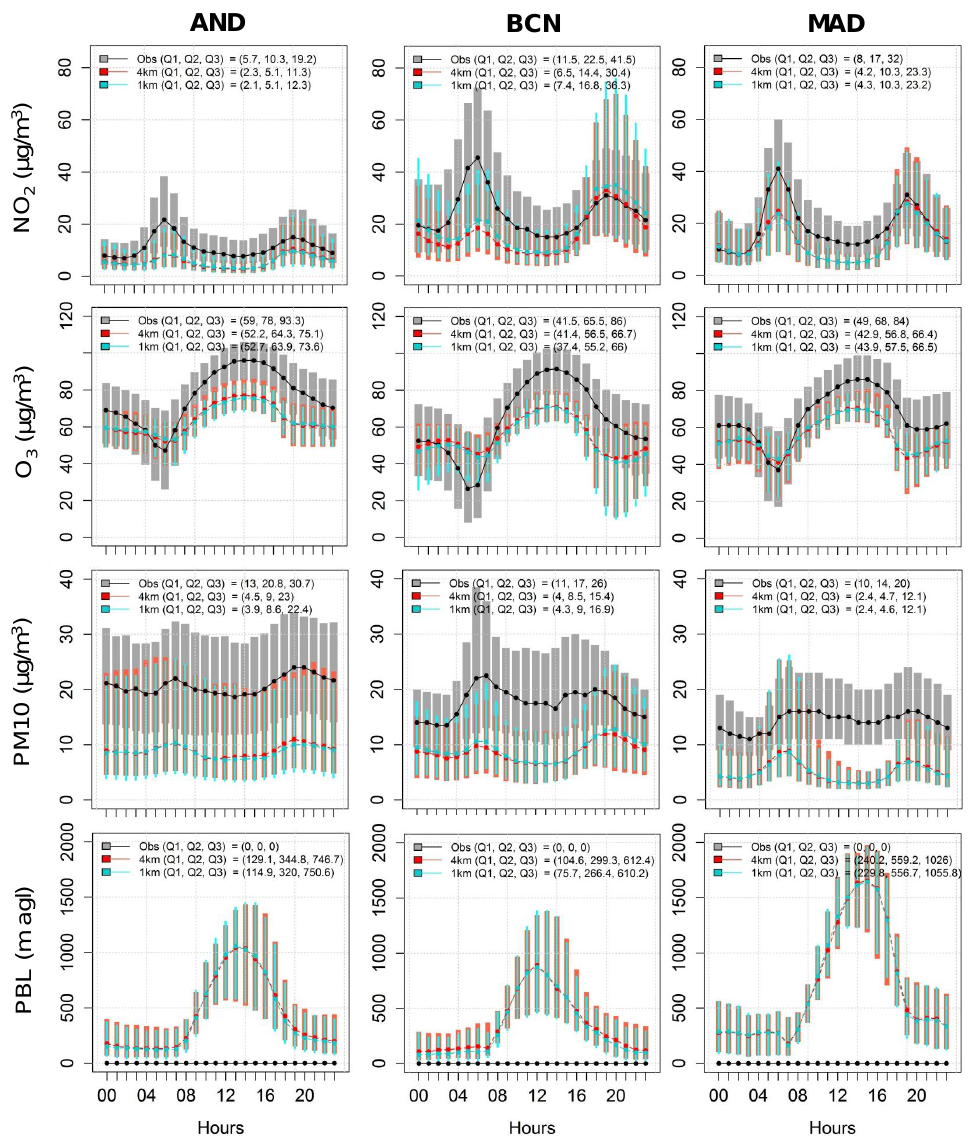
Figure 9. Daily cycles for NO 2 , O 3 and PM 10 for each study domain at available stations as a function of resolution. No observations of PBL are available. Q1, Q2 and Q3 indicate quartiles for the daily cycle. Bars show Q1 and Q3 at each